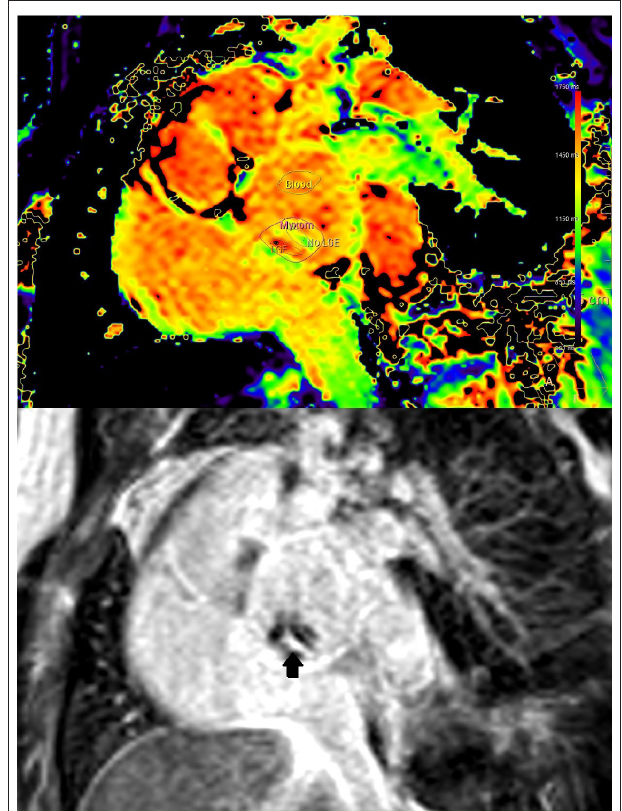
FIGURE 2 | (Case 1) Co-registration of LGE (lower image) and T1-mapping (upper image). Presence of LGE is defined as bright signal on LGE images (arrow). Where areas with and without LGE were discernible on mapping images of the same orientation, respective regions of interest where placed for differential